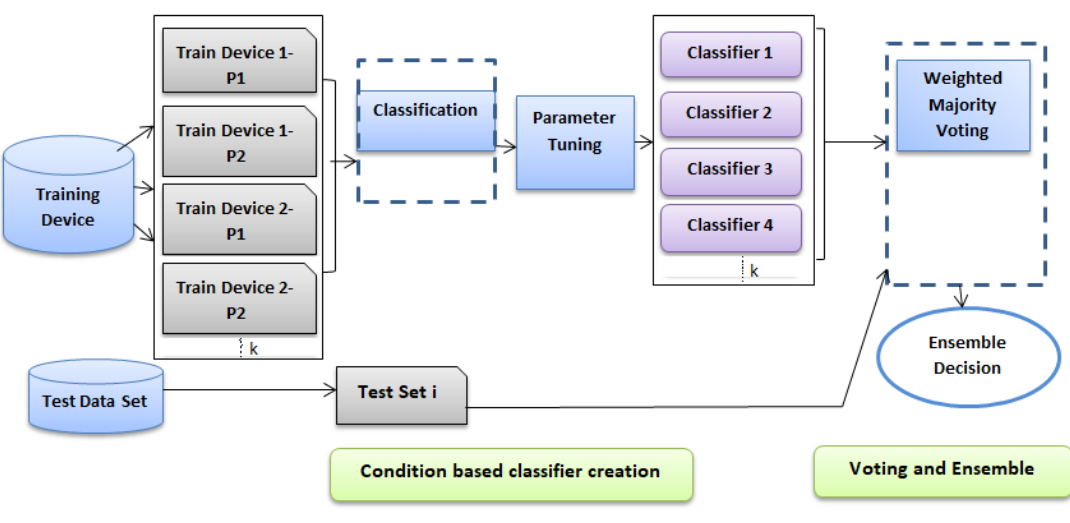
Figure 6. Block diagram of proposed ensemble based detailed activity recognition